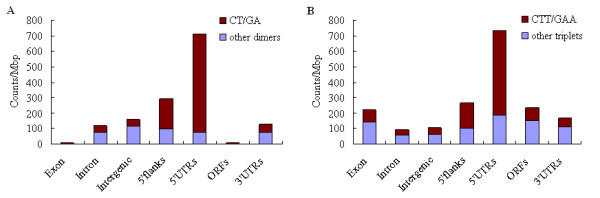
Distribution of microsatellites in different genomic regions in Arabidopsis. (A) Frequencies of dinucleotide repeats in different genomic fractions. Other dimers include all dimers except CT/GA repeats. (B) Frequencies of trinucleotide repeats in different genomic fractions. Other triplets include all triplets except CTT/GAA repeats. 5'-flanks correspond to the 500 bp sequences upstream of the initiation codon.